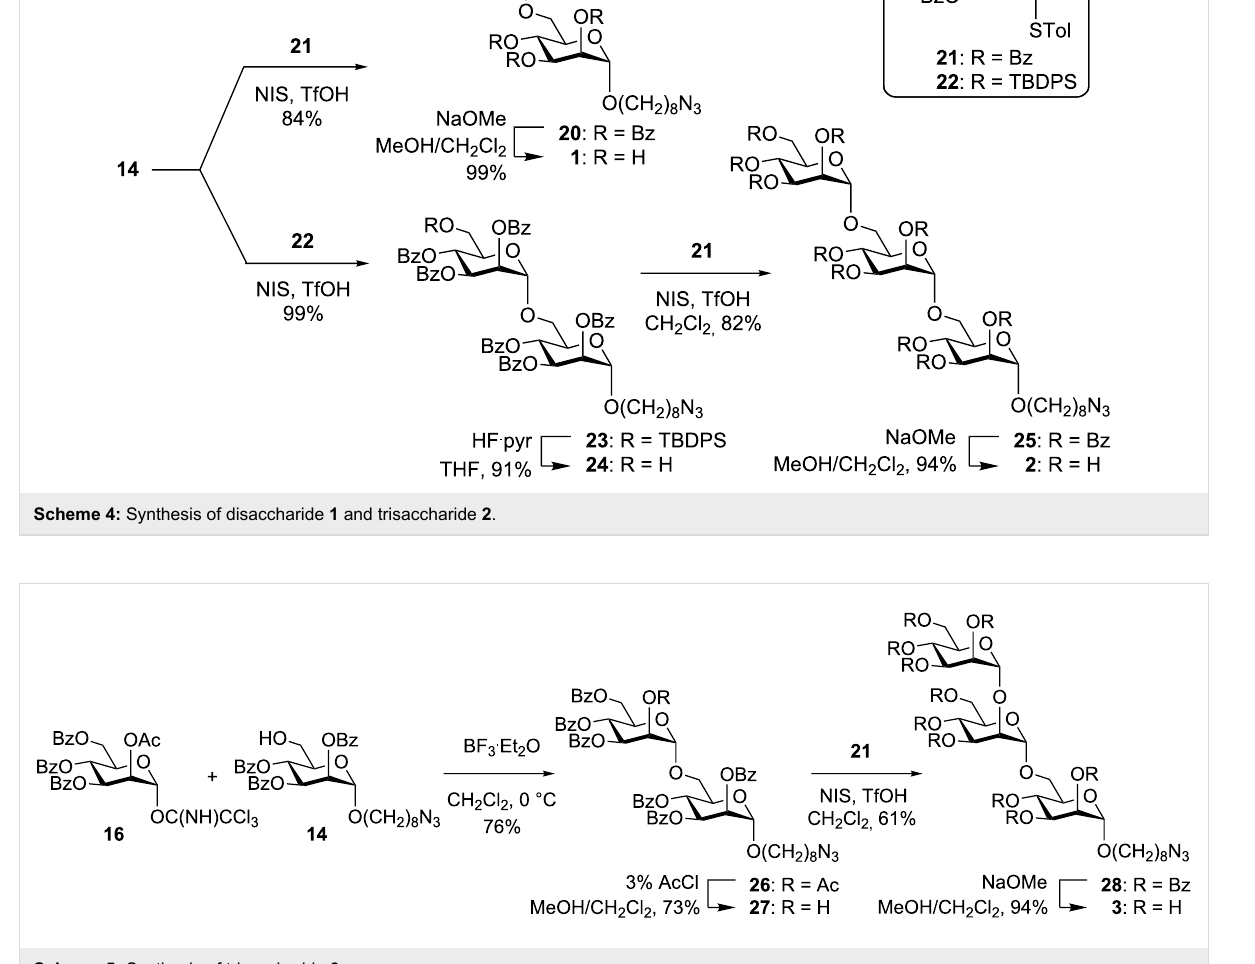
Scheme 5: Synthesis of trisaccharide 3 .